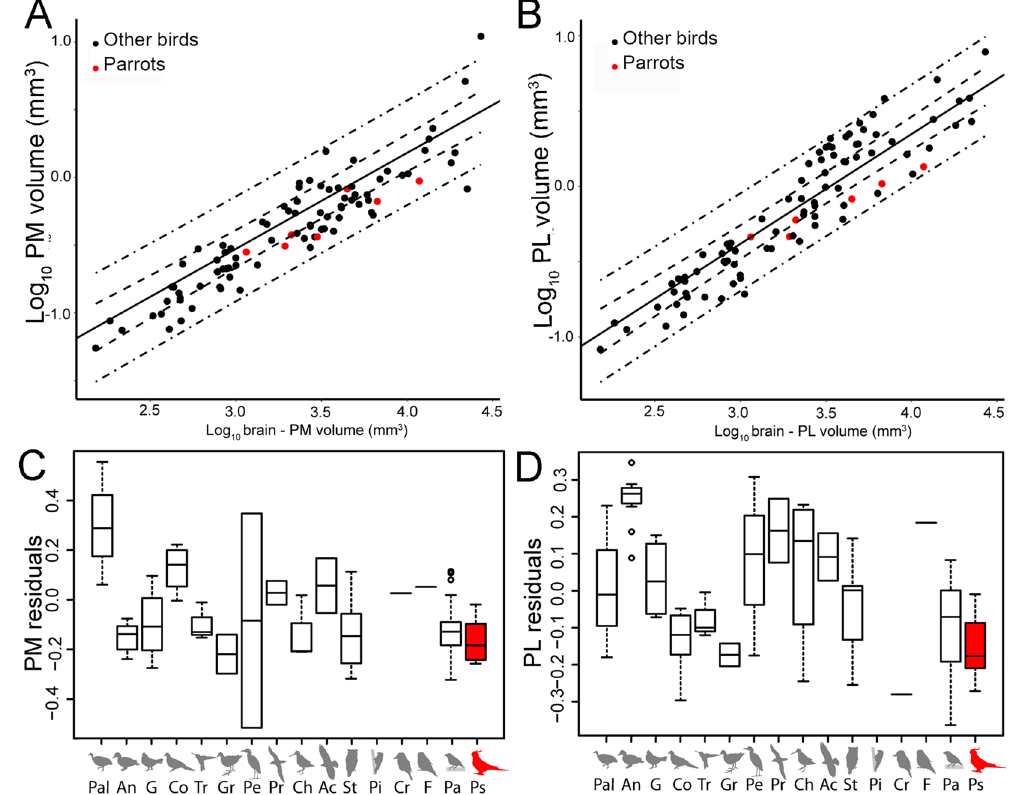
Figure 3. Relative size of the medial and lateral pontine nuclei (PM, PL). ( A , B ) The log-transformed volume of the PM and PL is plotted as a function of the brain volume minus the volume of each structure (PM = A; PL = B) for all species examined (see methods and supplementary materials, Table S1). Parrots (Psittaciformes) are shown in red. ( C , D ) Box plots show the relative size of PM ( C ) and PL ( D ) for each avian orders represented in this study. Parrots (Psittaciformes), are shown in red. Values shown in the box plots are derived from the residuals from PGLS of the log of the volume of each nucleus against the brain volume (see methods, panel A,B). The solid horizontal line represents the median, the two boxes represent the limits of the second and third quartiles and the whiskers (dashed vertical lines) represent the limits of the first and fourth quartiles. The open circles represent outliers, which are defined as those outside the first or fourth quartile by a magnitude of 1.5X the inter-quartile range. An = Anseriformes, Ch = Charadriiformes, Co = Columbiformes, F = Falconiformes, G = Galliformes, Gr = Gruiformes, Pa = Passeriformes, Pal = Paleognaths, Pe = Pelecaniformes, Pi = Piciformes, Pr = Procellariiformes, Ps = Psittaciformes, St = Strigiformes, Tr =